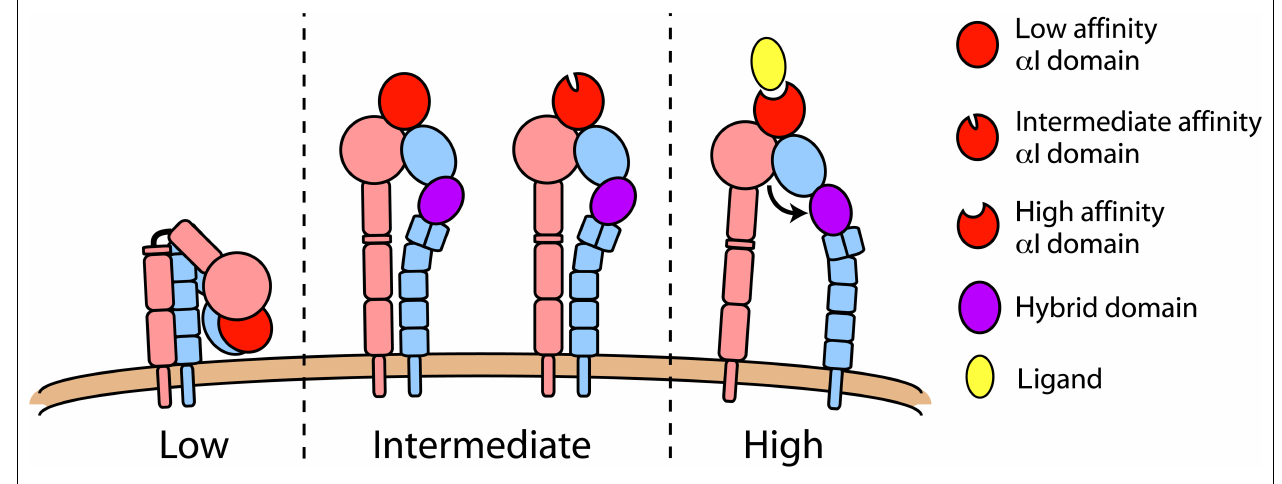
differ in the orientation of their hybrid domain (purple), with swingout of this domain representing a conversion from intermediate to high affinity state (right). Data suggest that the extended/closed conformation (middle) can have either a low or intermediate affinity α I domain.